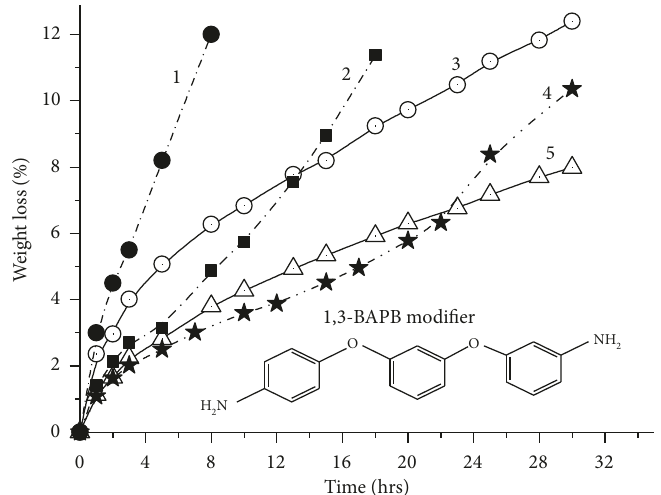
Figure 13: Time dependences of weight loss ( 100 Δ m / m ) of ROL-II-1,3-BAPB (I-X) blends and oligomerized 1,3-BAPB (XI) prepared by heating in the regime with T =320 ° С . Thermal oxidative aging was performed in air at 350 ° С . 1,3-BAPB content (wt.%): (1) 100, fin cur (2) 50, (3) 0, (4) 35, and (5) 10.